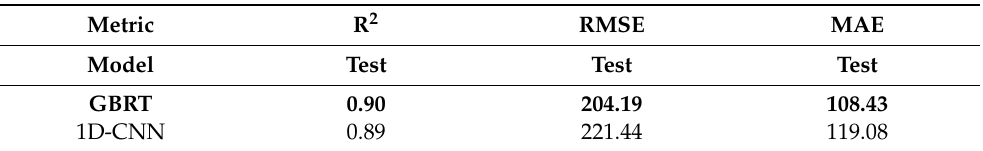
Table 7. A comparison of performance for Base specification data of GRBT and 1D-CNN models (valve train force).